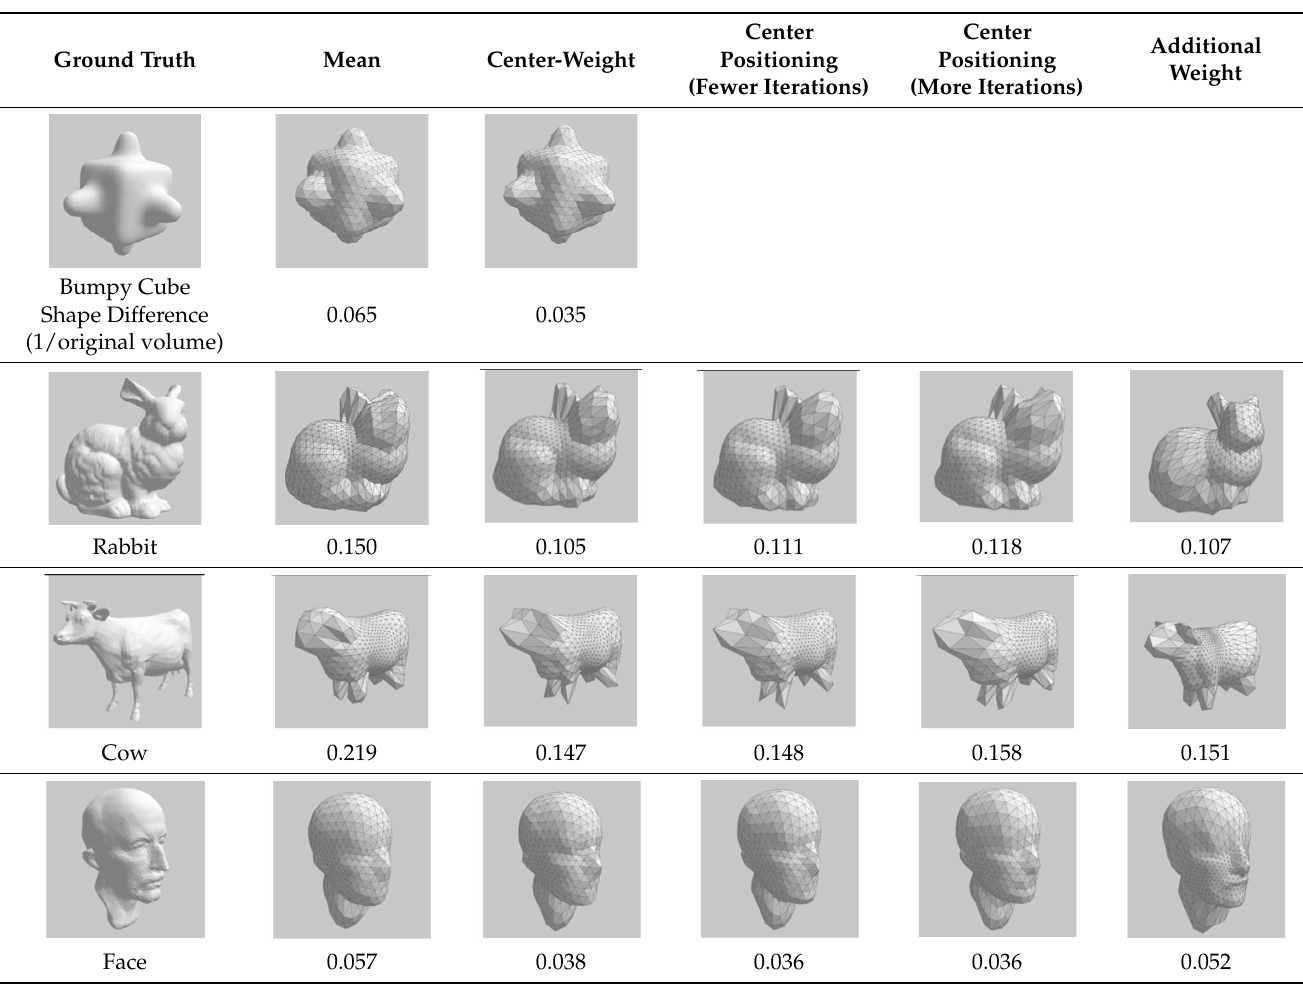
Table 3. Reconstruction and evaluation of target shapes depending on different shape reconstruction methods. Ground Truth Mean